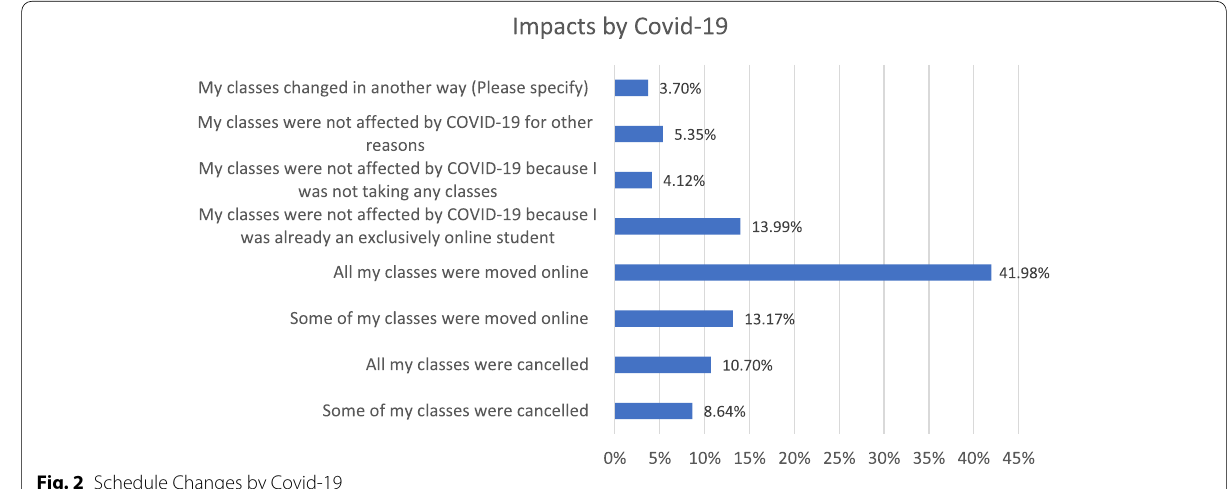
Fig. 2 Schedule Changes by